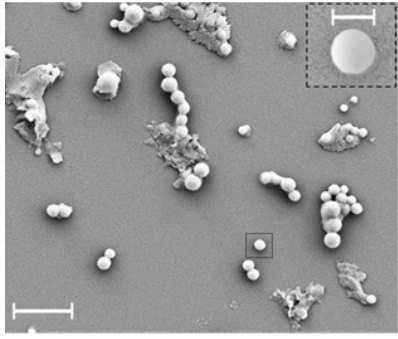
Figure 43. Scanning electron microscopy image of proteo-SLNs spread on a glass substrate (scale bars 1 µm and 200 nm (inset))